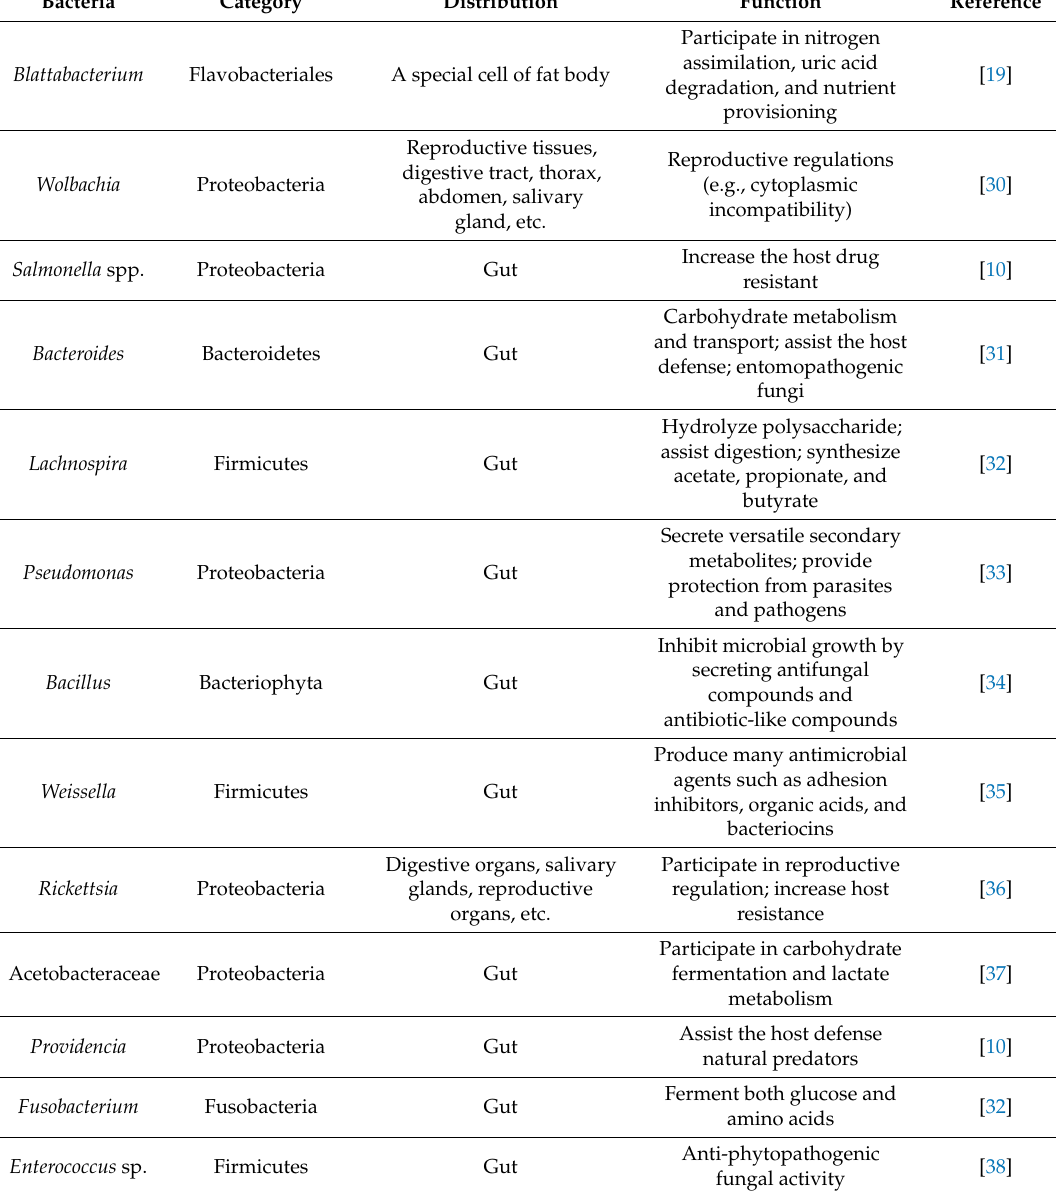
Table 1. The category, distribution, and function of some important symbiotic bacteria of